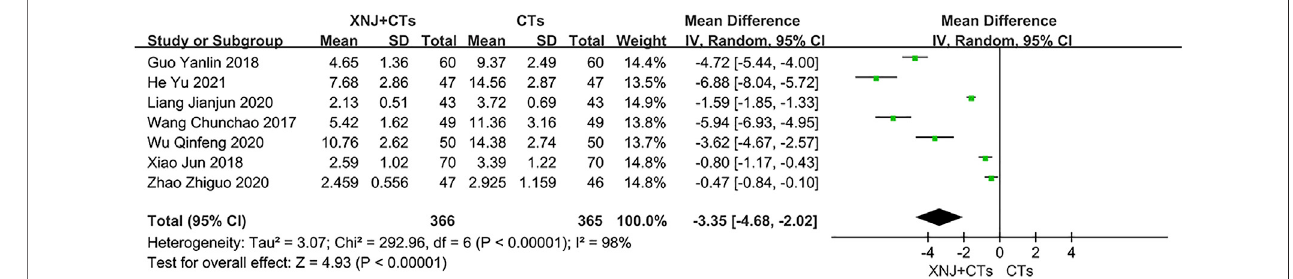
FIGURE 8 | Forest plot of hs-CRP.